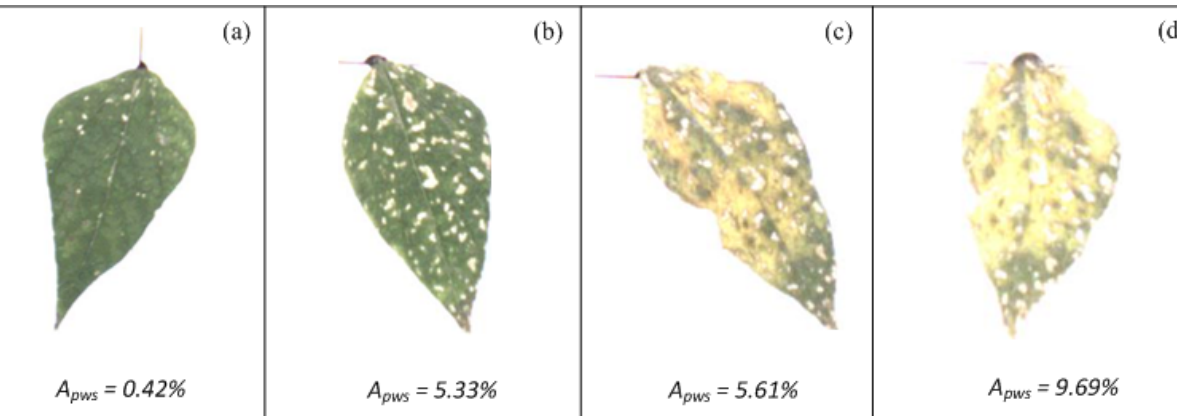
( a ) Bean leaf with the lowest percentage of leaf area occupied by white spots. ( b ) Bean leaf with intermediate percentage of leaf area occupied by white spots. ( c ) Chlorotic-bean leaf with intermediate percentage of leaf area occupied by white spots. ( d ) Chlorotic-bean leaf with the highest percentage of leaf area occupied by white